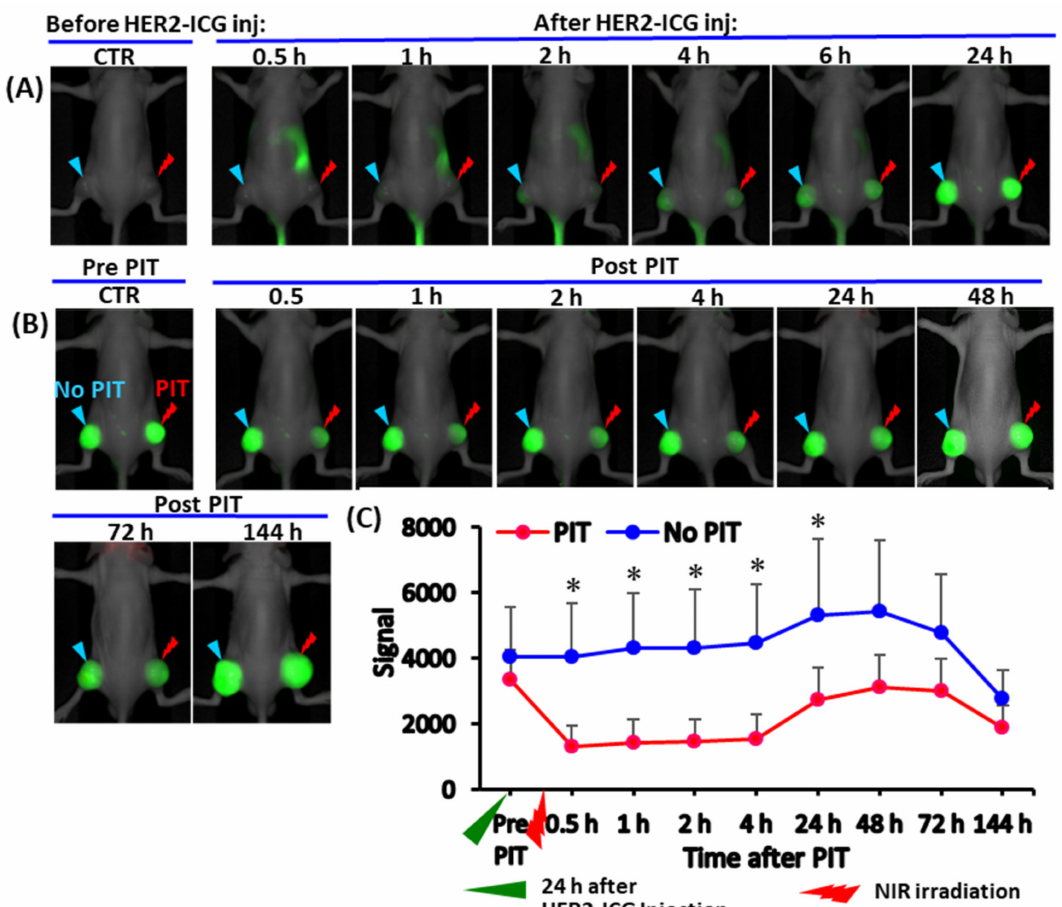
Figure 2. Serial whole-body NIR fluorescence images of a representative mouse bearing a xenografted tumor derived from an HER2-expressing A4 cell line. ( A ) Representative images at indicated time points (0.5, 1, 2, 4, 6 and 24 h) after intravenous injection of HER2-ICG (100 µ g). ( B ) Images of the same mouse were obtained pre- and post-photoimmunotherapy (PIT) at 0.5, 1, 2, 4, 42, 48, 72 and 144 h. The right tumor received NIR irradiation (PIT) and the left tumor was an untreated control tumor (no PIT). ( C ) Line graph showing the fluorescence signal intensity (SI) of HER2-ICG in tumors from each side. SI in the treated tumors decreased initially after PIT and increased again after 24 h, suggesting photobleaching of dye and cancer cell death. Data are presented as means ± SD ( n = 5), * p < 0.05 for PIT vs. no PIT. The green arrowhead indicates the time 24 h after the administration of HER2-ICG, and the red arrowhead indicates the day of NIR